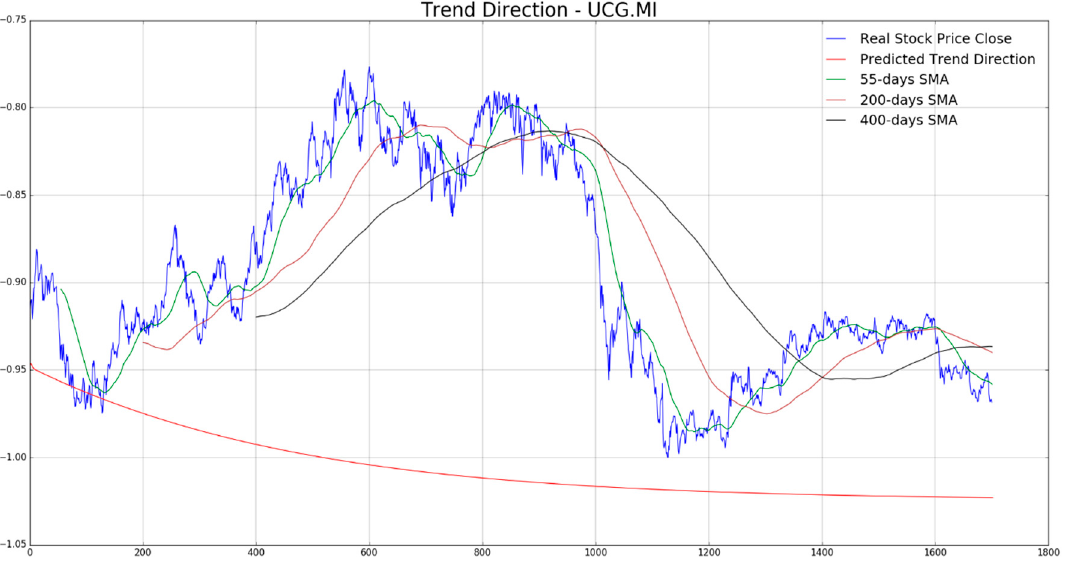
Figure 7. UCG.MI Trend Direction (red) and SMA.